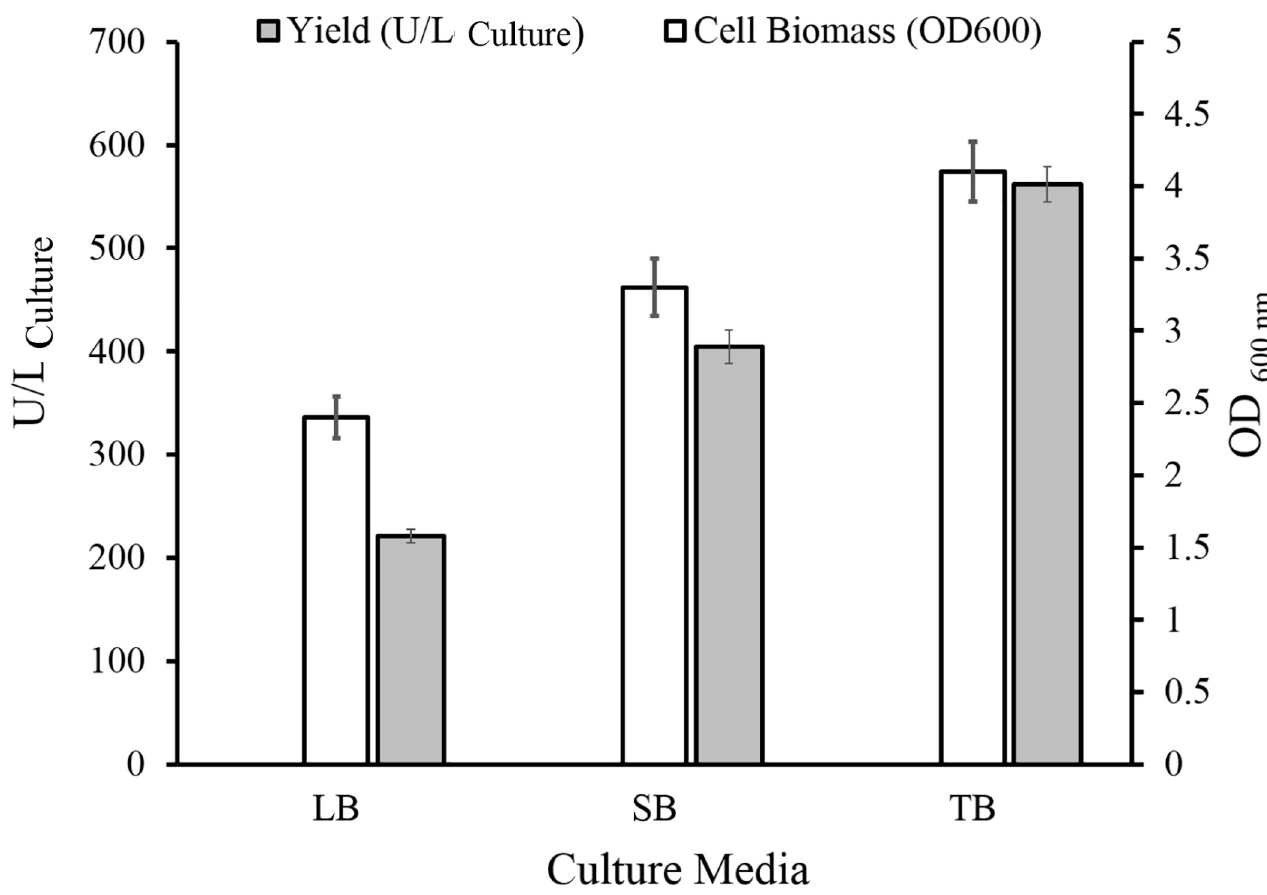
Fig 2. The effect of different types of culture media on cholesterol oxidase production and biomass accumulation. Rosetta-gami 2 (DE 3 ) -pET24- ChO was cultured in LB, SB, and TB media for 6 h post induction incubation time at 37˚C.